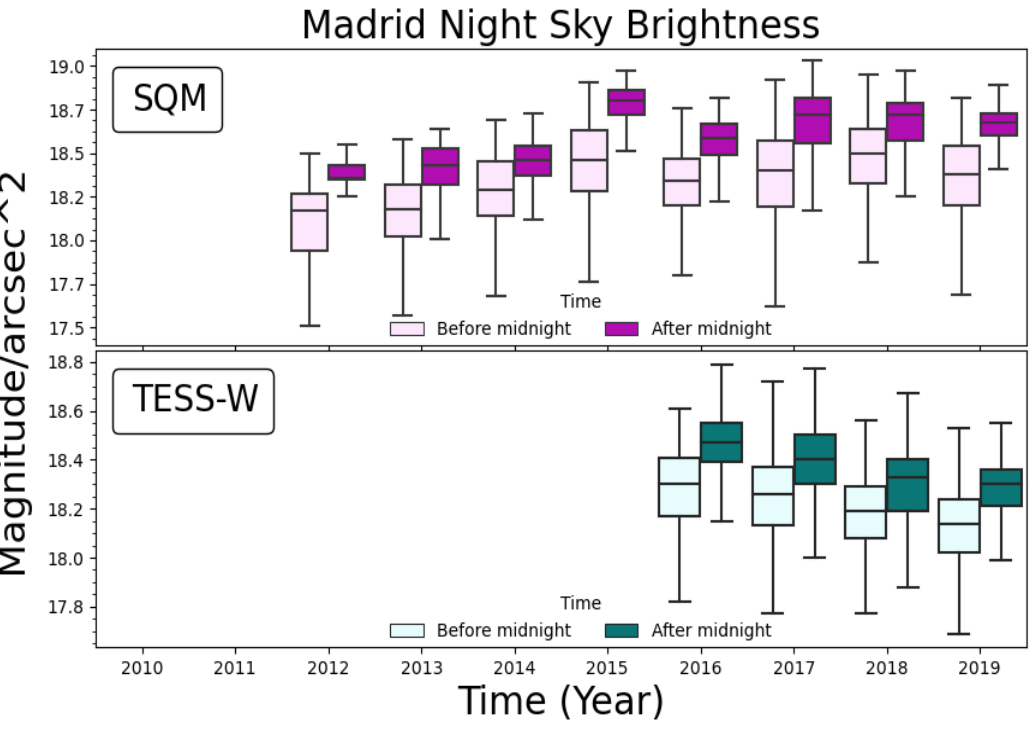
Figure 21. Median trends of SQM and TESS-W data before and after midnight.